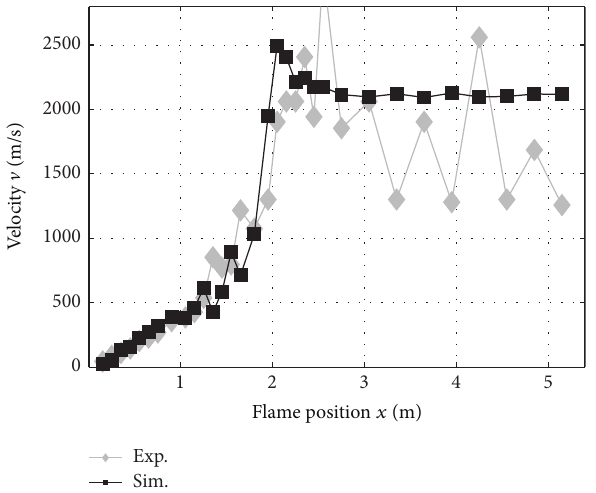
Figure 10: Flame velocity versus channel length for a mixture with 25% H 2 (max. concentration gradient).